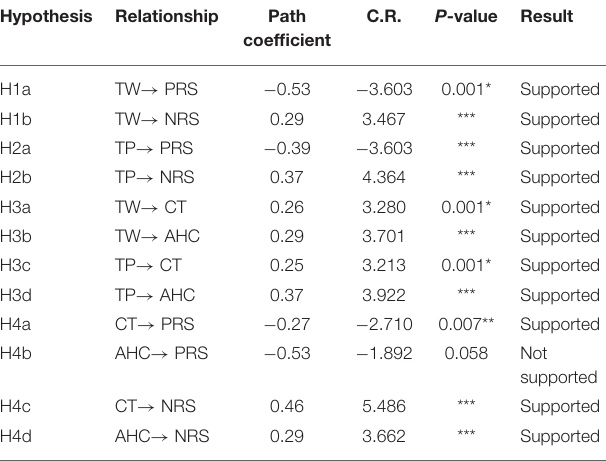
TABLE 4 | Results of path